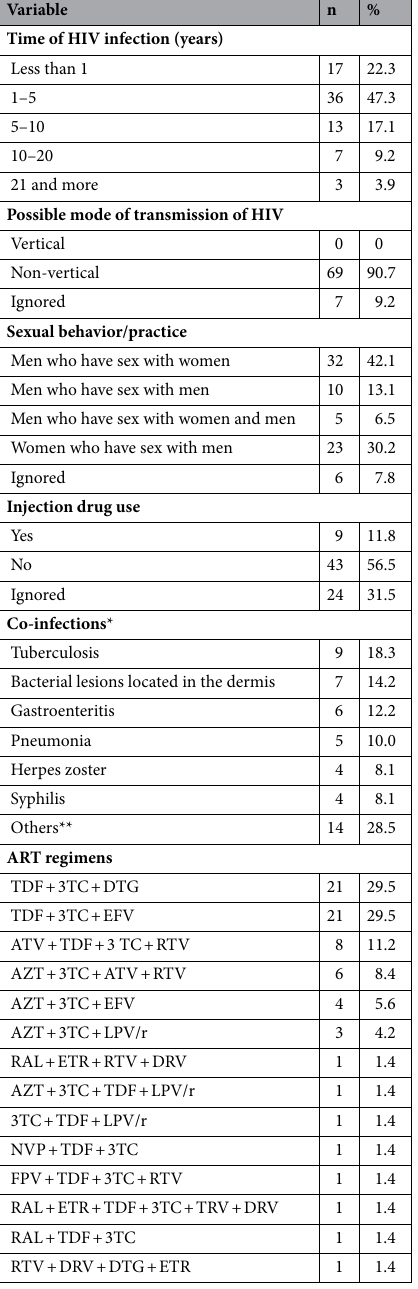
Table 2. Clinical–epidemiological data of the study population ( n = 76). Data source: Notifiable Diseases Information System (SINAN) and outpatient and hospital records. *Data from medical records.